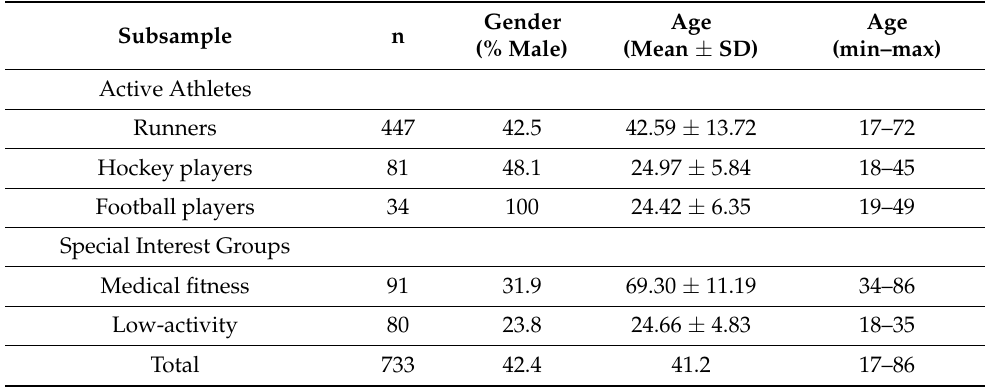
Table 2. Demographic characteristics of the study population (n =